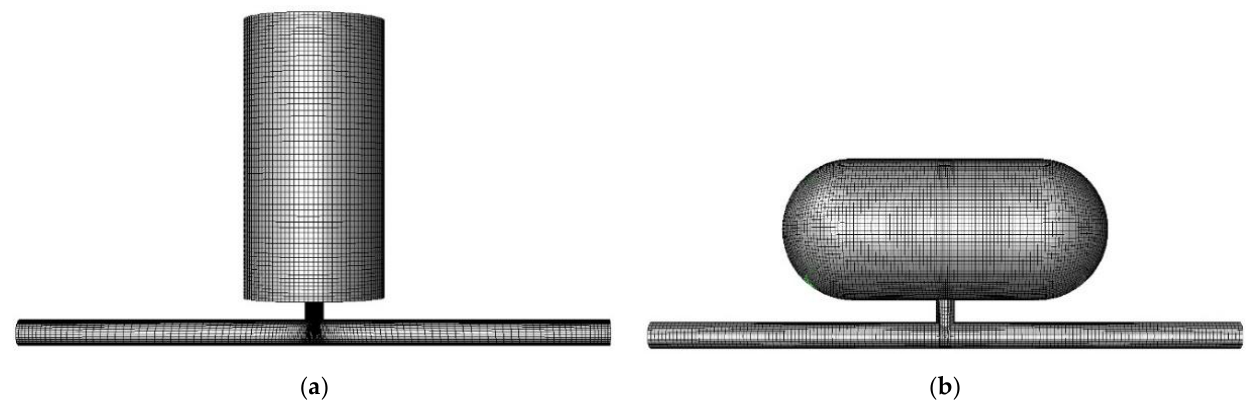
Figure 2. Computational domain of two models of 3D simulation. ( a ) Vertical ACSC; ( b ) Horizontal ACSC. Table 2. Mesh independent analysis of the horizontal ACSC.